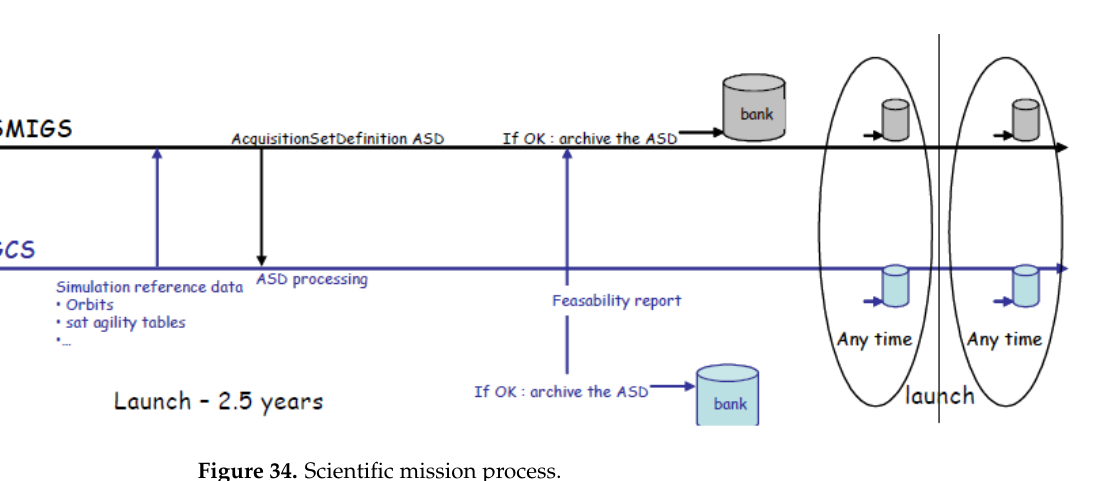
Figure 34. Scientific mission process.